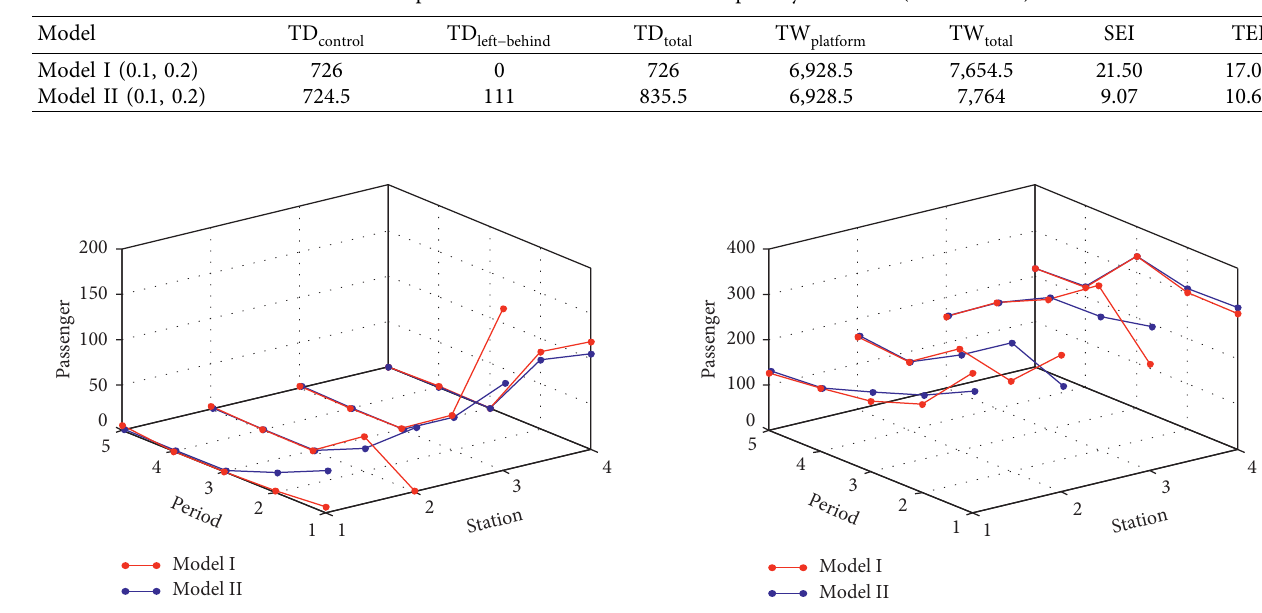
Figure 9: Comparison of waiting passengers at the platform in two models.